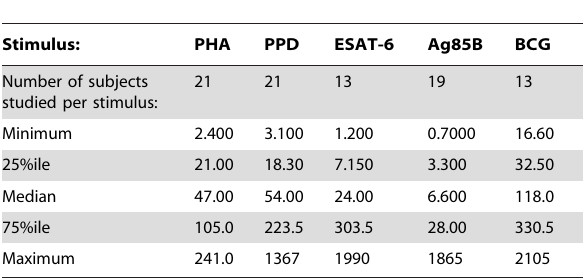
Table 2. Descriptive Statistics of IFN- c /IL-17